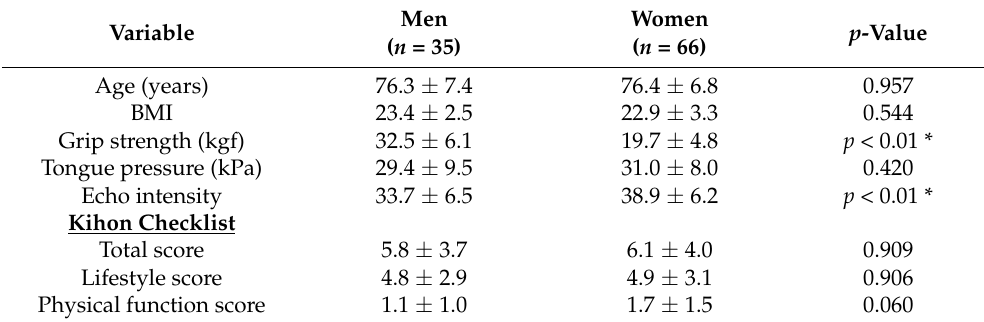
Table 2. Assessment results of tongue function and frailty (means ± standard deviations). Men Variable ( n = 35)